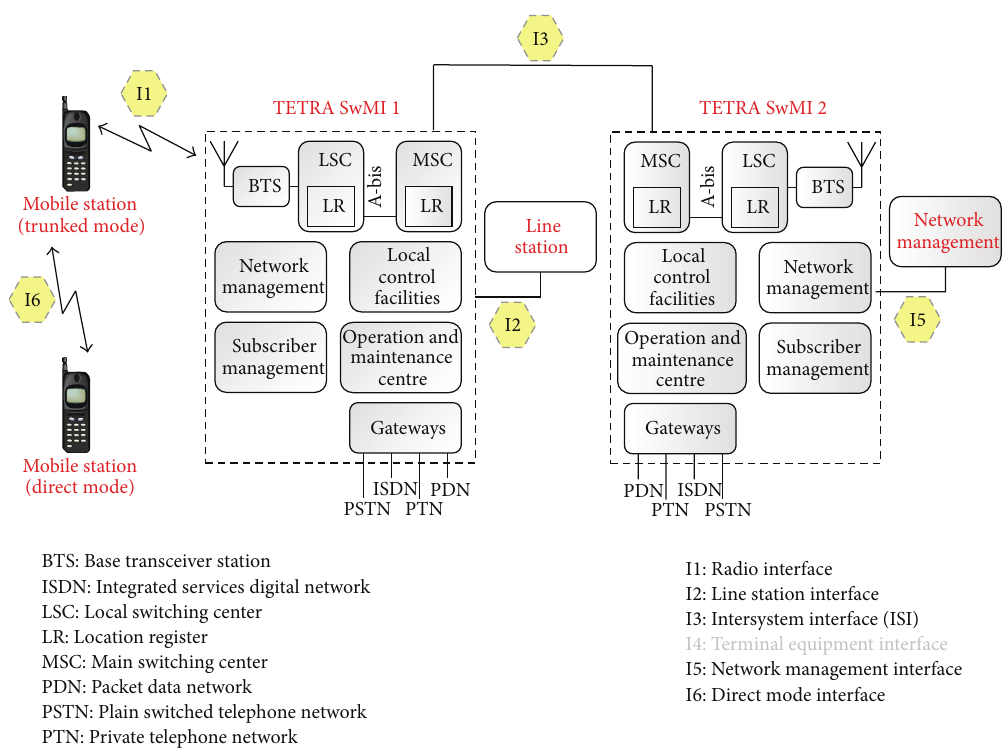
Figure 1: TETRA network architecture